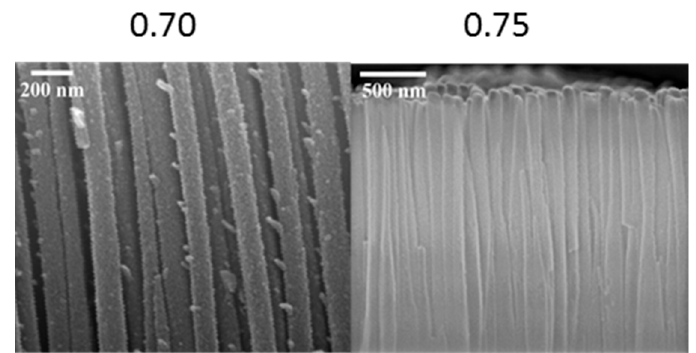
Figure 3. FESEM cross-section images for nanorod structures grown at N 2 :(N 2 + CH 4 ) flow rate ratio of 0.70 and 0.75. Selected magnifications of the images were used for clarity.